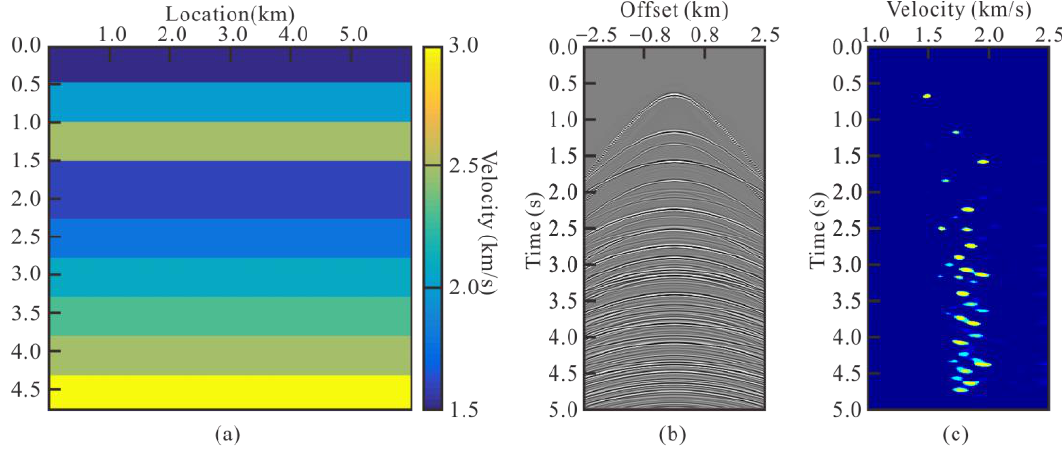
Figure 4. Display of synthetic data: ( a )Velocity model containing a velocity reversal, ( b ) CMP record of original data, ( c ) velocity spectra of original data.